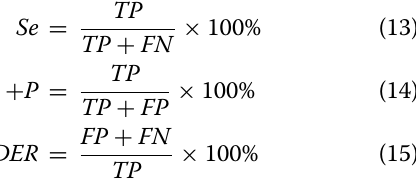
and the positive predictivity (+P) and the detection error rate (DER) were calculated using the following equations,